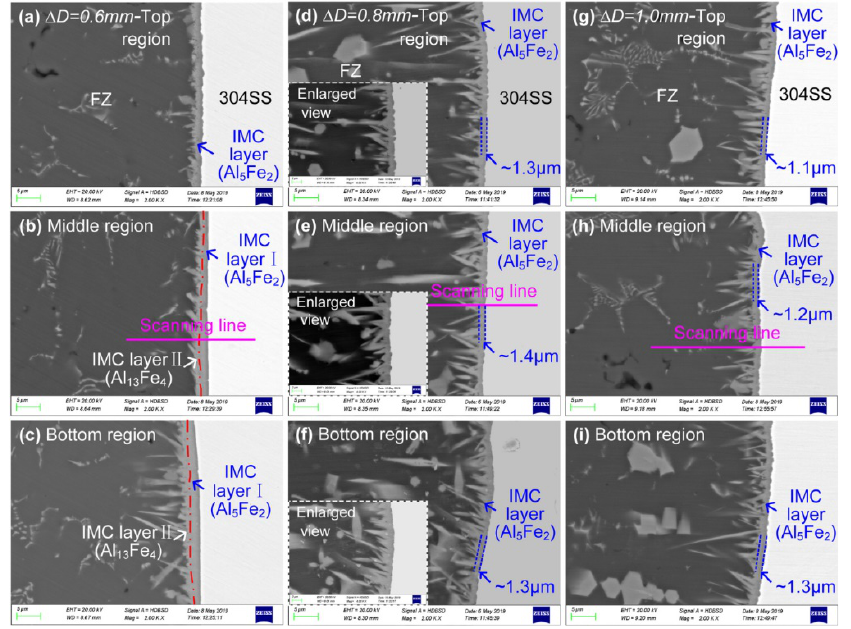
Figure 13. FZ/304SS interface obtained at different laser offset, ( a – c ) Δ D = 0.6 mm, ( d – f ) Δ D = 0.8 mm, ( g – i ) Δ D = 1.0 mm [33].